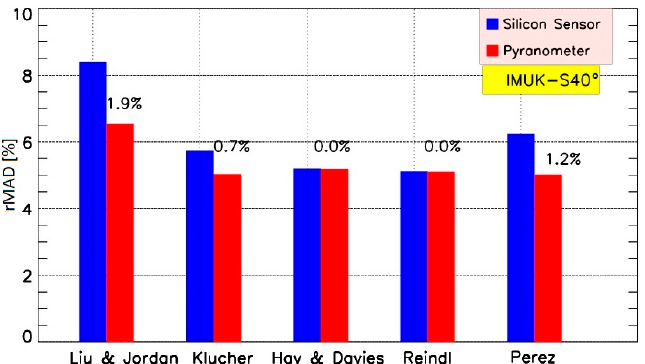
Figure 5. Dependence of the rMAD on the used sensor for the five transposition models. The performance of models is better if the model input data (GHI) and validation data (GTI) are measured by sensors of the same type.